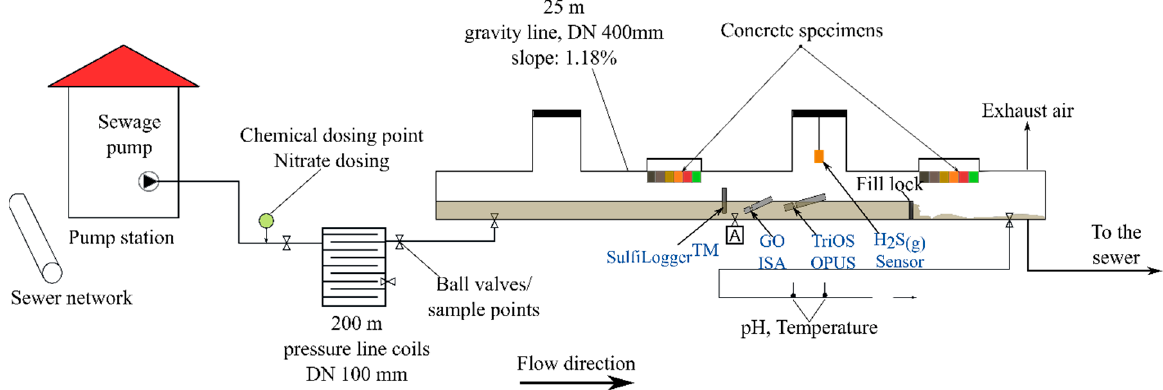
Figure 1. Schematic layout of the Berlin Water Company Research Sewer Pilot Plant (RSPP). The sensors evaluated are in blue. Wastewater samples collected for comparison withdrawn at ball-valve (A).